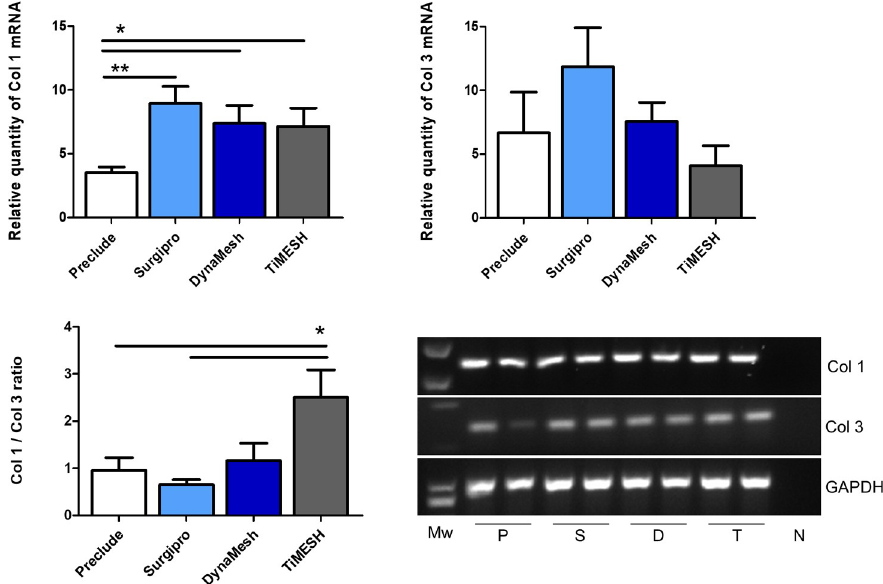
Fig 13. Collagen 1 and 3 mRNA expression levels determined by RT-PCR in non-injured omentum. Relative mRNA levels of collagen 1, collagen 3 and Col1/Col 3 ratios in samples of omentum (non-injured and not involved in adhesions) from animals implanted with different meshes. Gene expression was normalized to the expression recorded for the reference gene GAPDH. Agarose gel electrophoresis of RT-PCR products is shown: P, Preclude; S, Surgipro; D, DynaMesh; T, TiMESH. Mw: Molecular weight markers. N: Negative. All reticular meshes showed statistically significant higher collagen 1 mRNA expression levels compared to the laminar Preclude ( �� , p < 0.01 vs. Surgipro and � , p < 0.05 vs. DynaMesh, TiMESH). Col 1/ Col 3 ratios were greatest in TiMESH vs. Preclude or Surgipro ( � , p < 0.05).